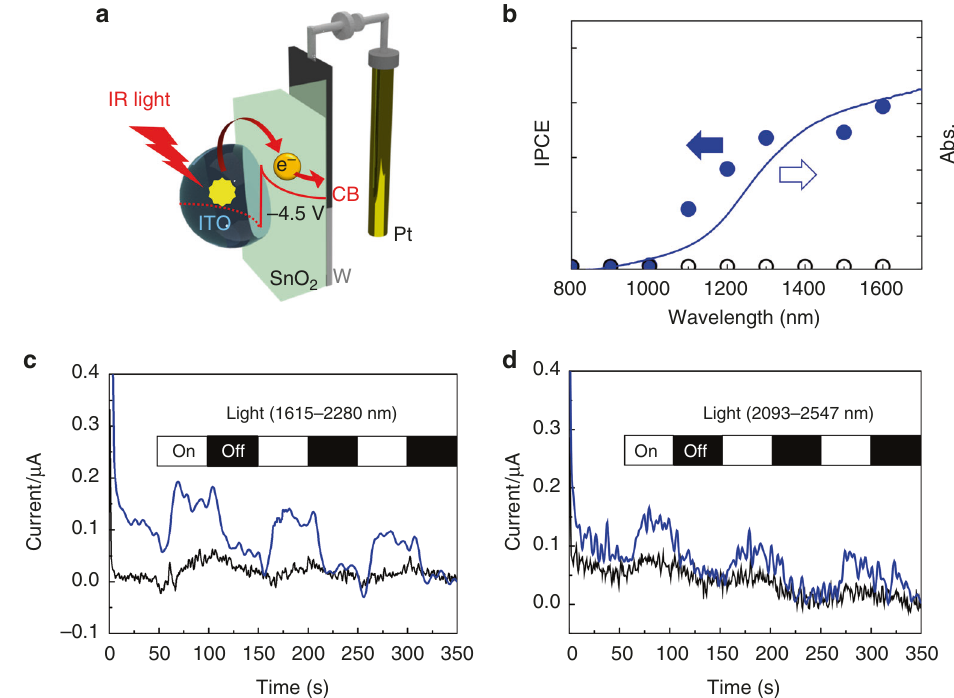
Fig. 4 Illustration of IR-light-to-energy conversion and photoelectrochemical measurements. a The photoelectrochemical cell con fi guration and schematic illustration of IR-light-to-energy conversion using the plasmonic ITO/SnO 2 heterointerface (the reference electrode is omitted for clarity). b Action spectra of ITO-NC/SnO 2 /W photoelectrodes. The fi lled and empty blue circles correspond to the ICPE of the ITO-NC/SnO 2 /W electrode and the SnO 2 /W electrode, respectively. The blue solid line is the diffuse-re fl ectance spectrum of the ITO-NC/SnO 2 /W electrode. IPCE measurements under irradiation by light of wavelengths longer than 1600 nm was not carried out due to the limitations of our instrument. Experiments were performed in an acetonitrile solution of triethanolamine (10% v/v) containing 0.1-M tetrabutylammonium hexa fl uorophosphate. c , d Photoelectrochemical measurement of an ITO NCs/SnO 2 /W electrode under SWIR irradiation. Short-circuit photocurrent and time (I-t) curves under irradiation by a chopped Xe lamp through a broadband pass fi lter (1615 nm – 2280nm, 104 mW cm − 2 or 2093 nm – 2547 nm, 33 mW cm − 2 ) using a three-electrode setup (blue line). (Working electrode: ITO NCs/SnO 2 /W electrode; Reference electrode: Ag + /Ag; Counter electrode: Pt wire; Photoactive area: 2.5 × 1.5 cm 2 ; Solution: acetonitrile solution of triethanolamine (10% v/v) containing 0.1-M tetrabutylammonium hexa fl uorophosphate). The black line is an I-t curve obtained using the SnO 2